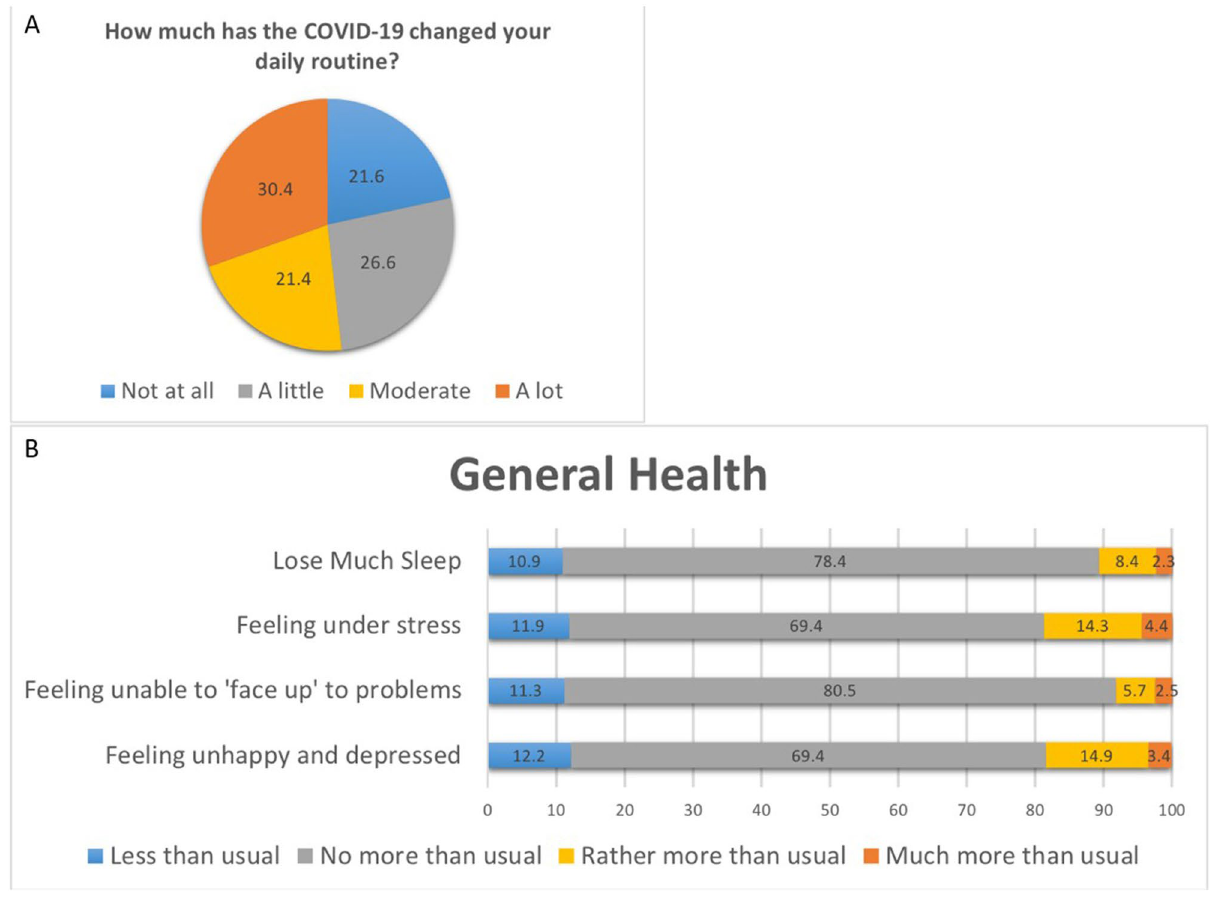
Figure 2. Impact of COVID-19 on respondents’ daily routine, general health, and